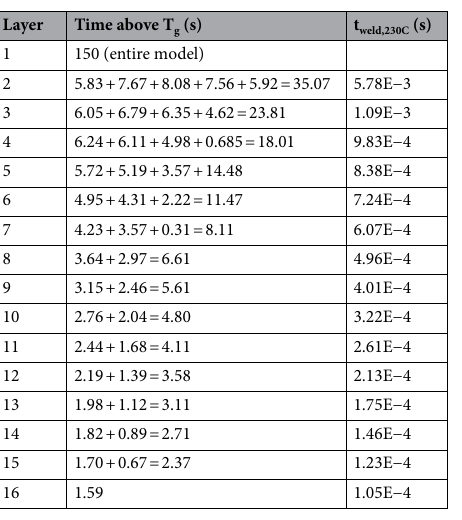
Table 3. Time above T g for each layer and total isothermal weld time of the baseline model (T ext = 230 °C, v print = 30 mm/s, h = 0.3 mm). The time for each segment that a layer is above T g is listed and then added together to give the total weld time. Isothermal weld time between layers n and n − 1 is evaluated at a reference temperature of 230